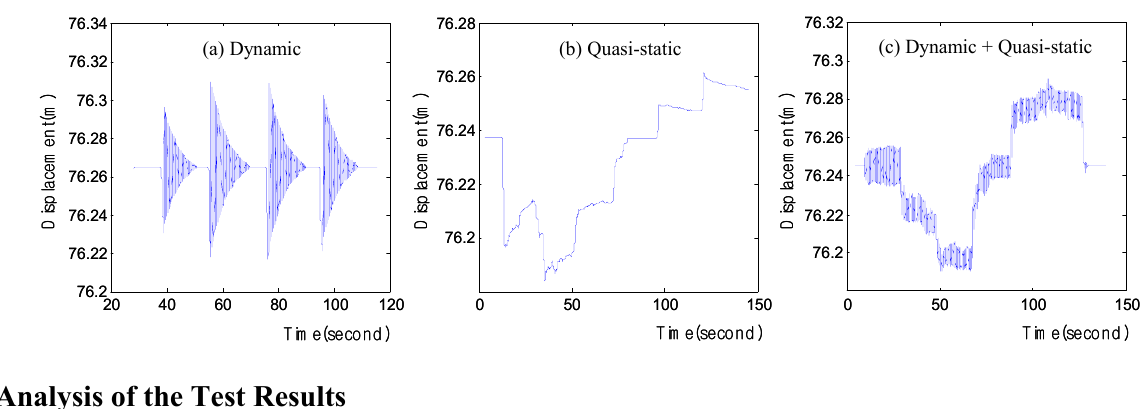
Figure 7. Three types of displacement measurement.